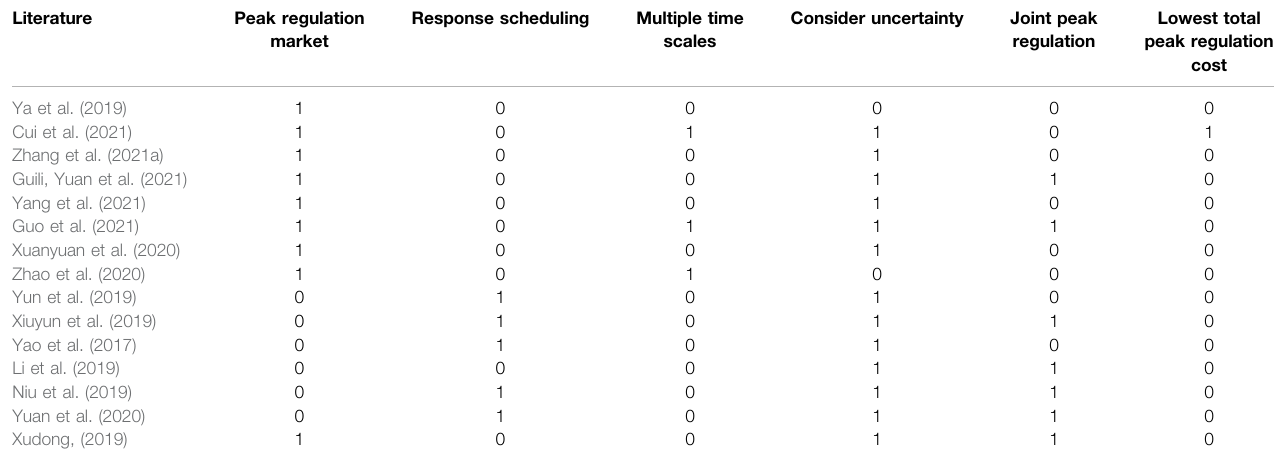
TABLE 1 | Reference comparison table.